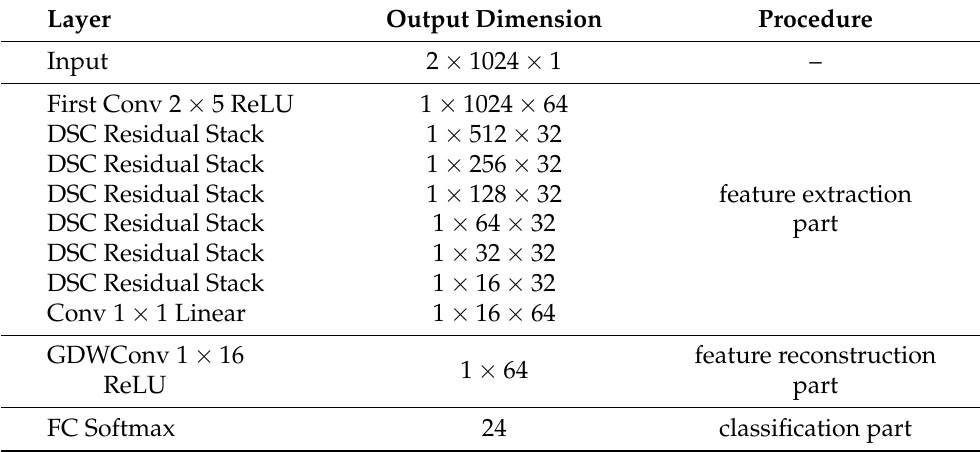
Table 2. Proposed LWAMCNet